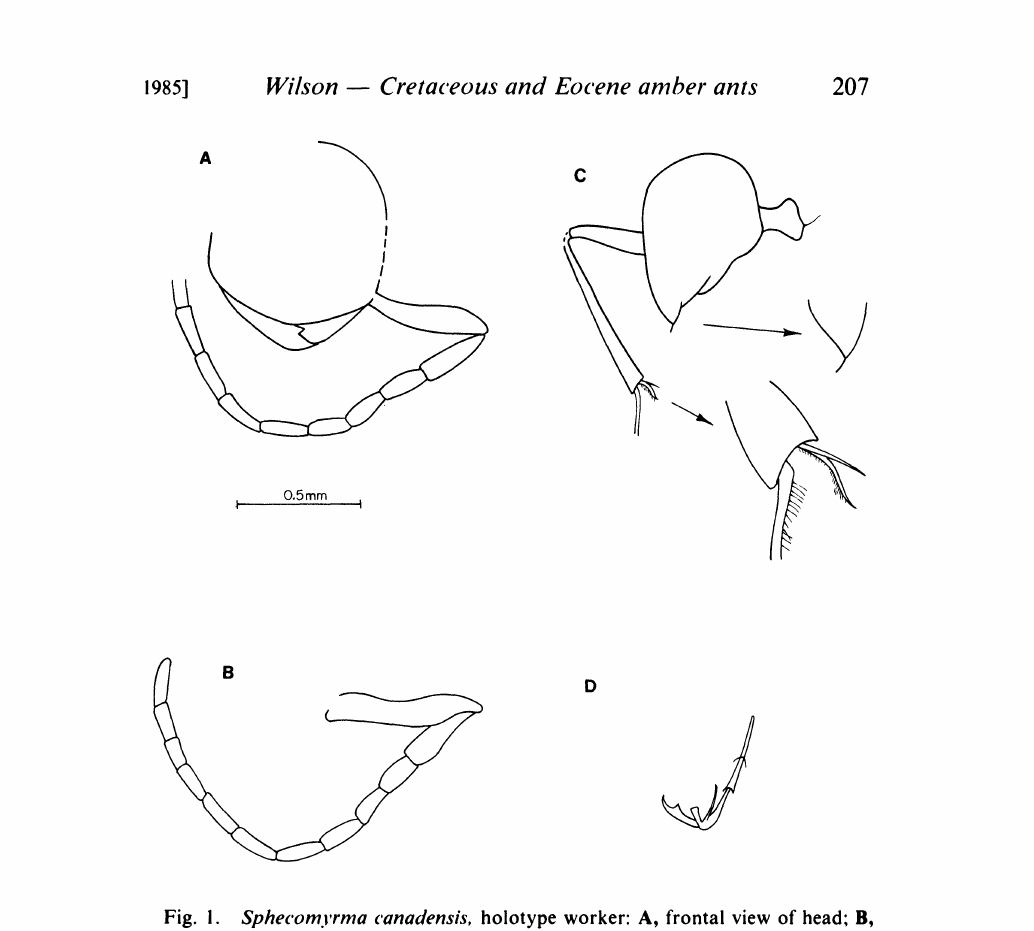
Fig. 1. Sphecomyrma canadensis, holotype worker: A, frontal view of head; left antenna, dorsal view; (2, gaster, petiole, and left rear leg, with enlarged views of the rear-leg tibial comb and spur and tip of abdomen (showing the extruded sting); D, left front